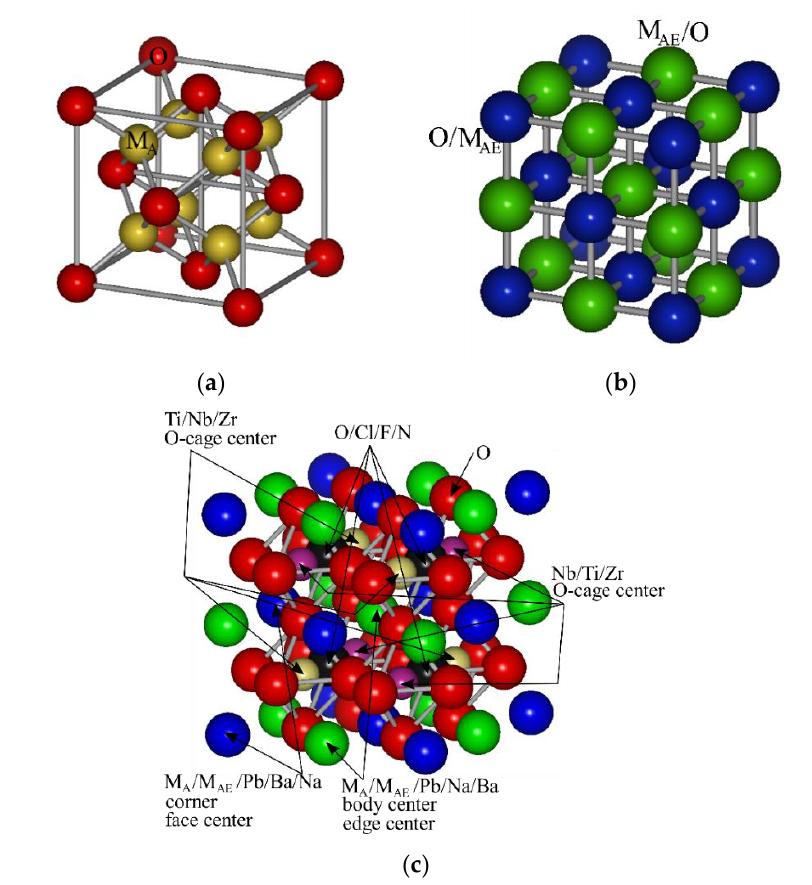
Figure 2. Cluster models for the calculation. ( a ) is an antifluorite structure (M A ) 2 O with oxygens colored red. ( b ) is a sodium chloride structure (M AE )O with M AE body-centered; M AE and O are each colored green and blue, and exchanging the colors provides the oxygen body-centered structure. ( c ) is a double perovskite structure. The green spheres and the blue spheres are M A , M AE , Pb, Na, or Ba. The gold spheres and purple spheres are Ti, Nb, or Zr. The black spheres are O, Cl, F, or N. The red spheres are oxygens. Chemical species are located so that symmetry D 2 is maintained. The colors of ions in each model are summarized in Table 1. Table 2. Lattice parameters used for modeling.